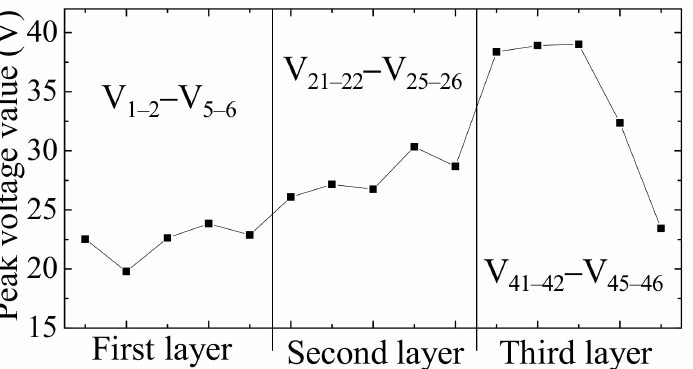
Figure 13. Overvoltage ratio between adjacent turns in different